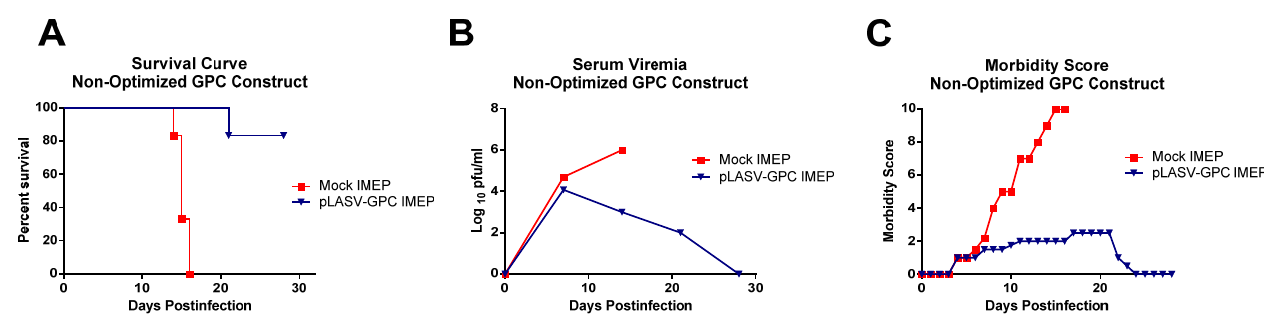
Figure 2. Outcomes for IMEP study using the non-optimized LASV DNA construct. ( A ) Survival curve; ( B ) Serum viremia as measured by plaque assay; ( C ) Morbidity score based on observed disease signs.